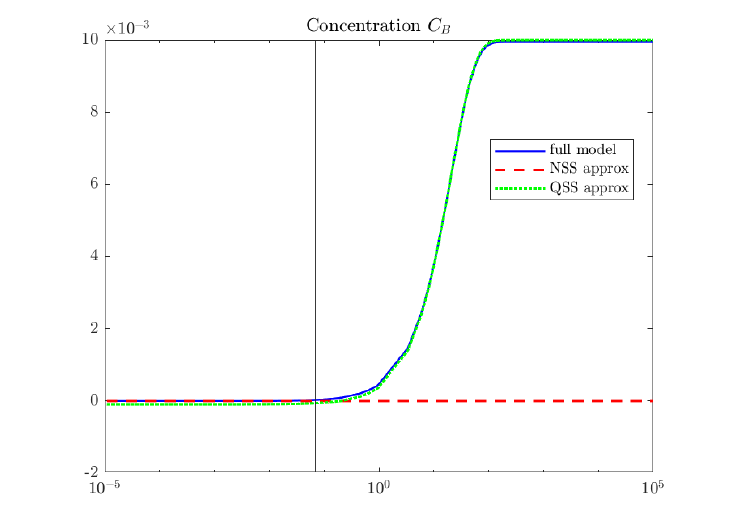
Figure 3. Concentration of B.